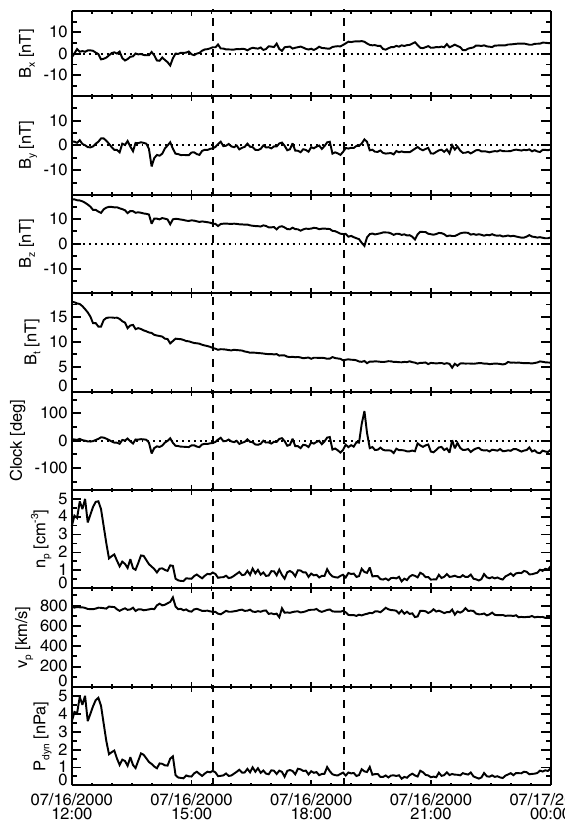
Fig. 1. Solar wind and IMF conditions on 16 July 2000, as observed by ACE in GSM coordinates. The interval of stable IMF conditions is marked by vertical dashed lines. See text for details.